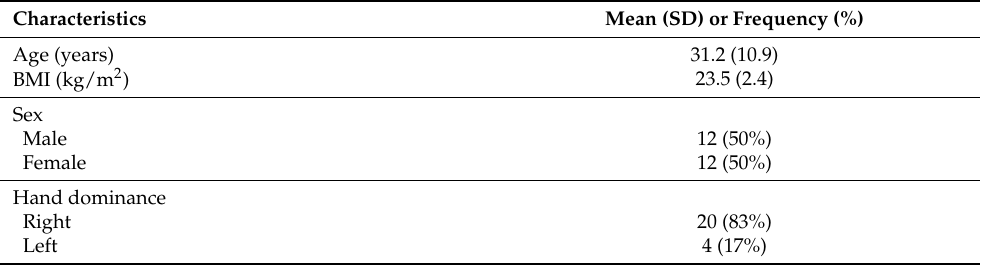
Table 1. Characteristics of patients (n = 24).